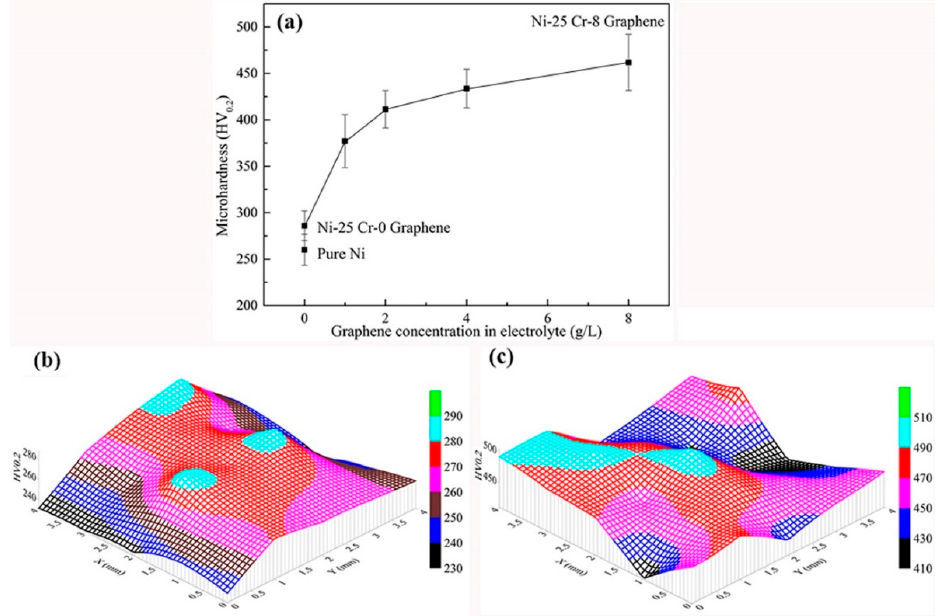
Figure 12. Micro-hardness variation of the Ni–Cr–graphene coatings ( a ); surface micro-hardness distribution of the pure Ni ( b ) and Ni-25–Cr-8–graphene ( c ) coatings.